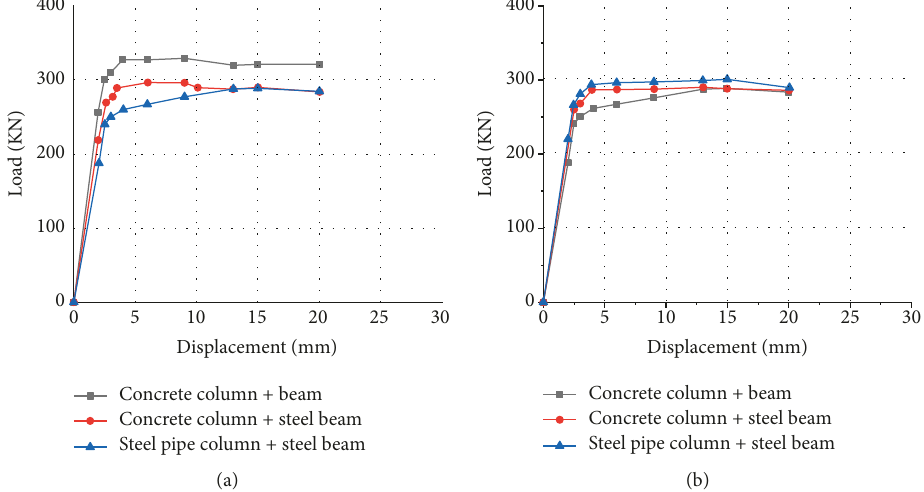
Figure 7: Simulation results of the ultimate bearing capacity of the steel beam joint: (a) bolt-type combination; (b) external diaphragm-type combination.